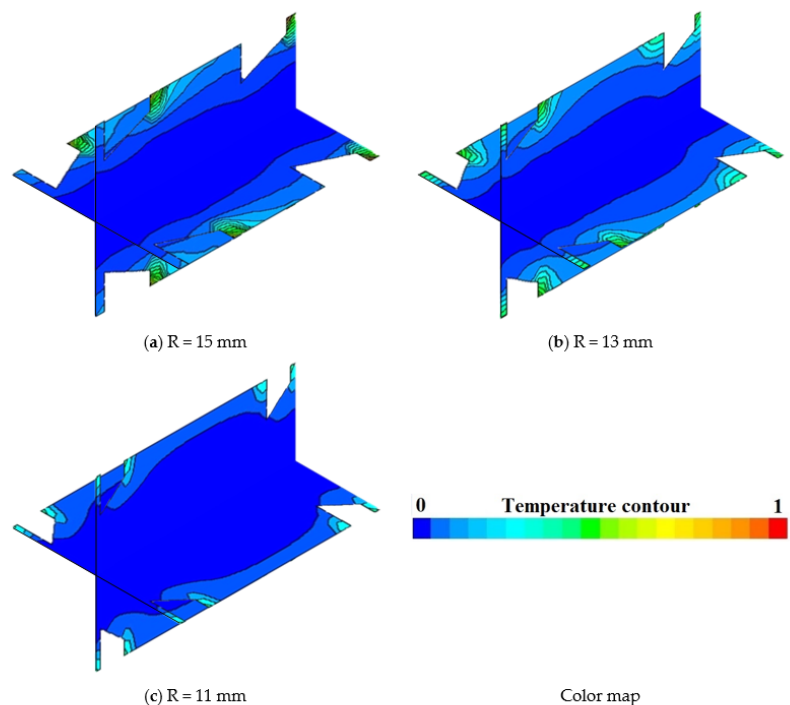
Figure 21. Temperature contours for various configurations of Case C with different R parameters at C 2 = 24 mm, Re = 15,000, and ϕ = 0.5%.